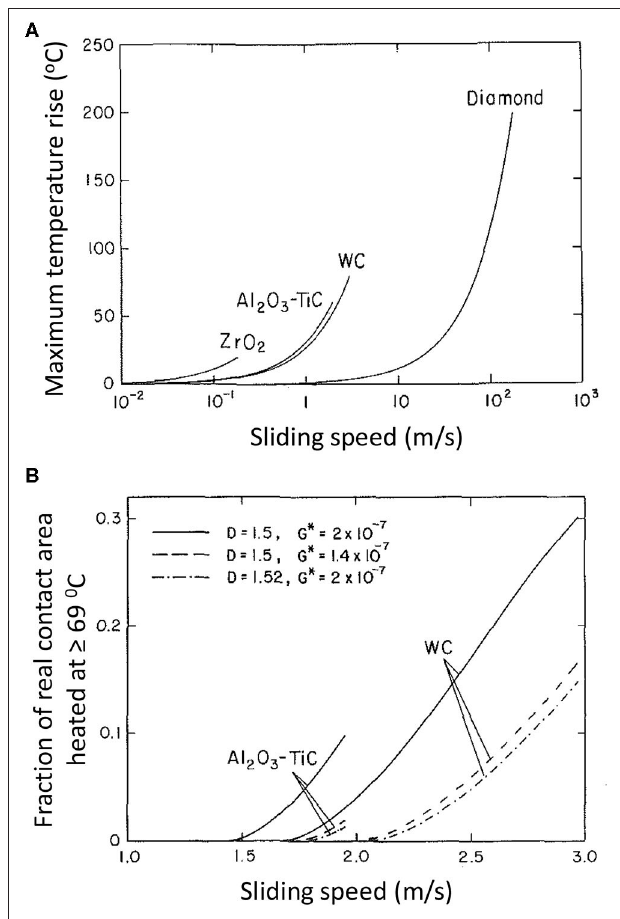
FIGURE 8 | (A) Maximum temperature rise on 2D fractal ceramic and diamond surfaces vs. sliding speed for D effect of fractal parameters D and G * on the fraction of real contact area at a temperature 69 o C vs. sliding speed for Pe < 0.5 and µ ≥ Komvopoulos, 1994b ).